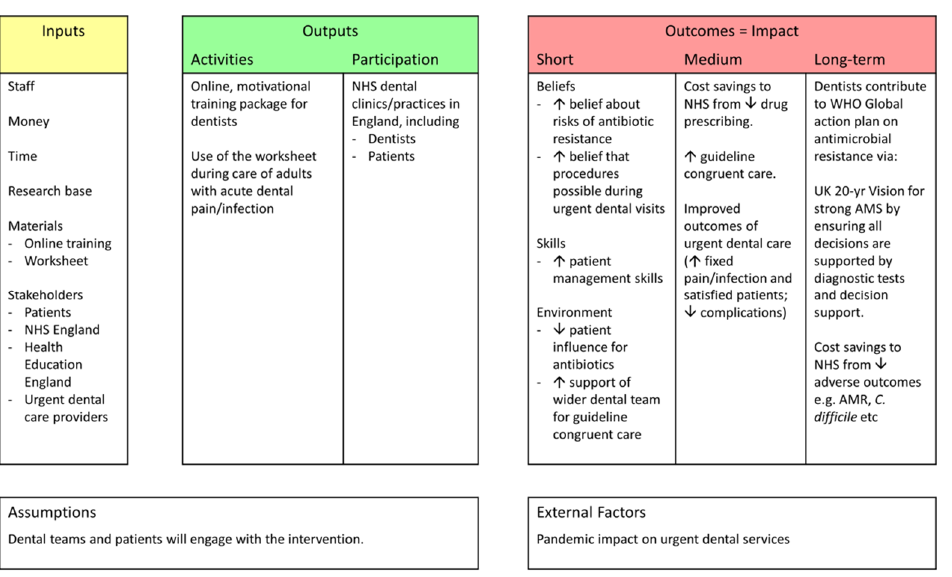
Figure 3. Logic model for the shared decision-making, dental antibiotic stewardship intervention (including the worksheet tool and accompanying online, motivational training package). (including the worksheet tool and accompanying online, motivational training